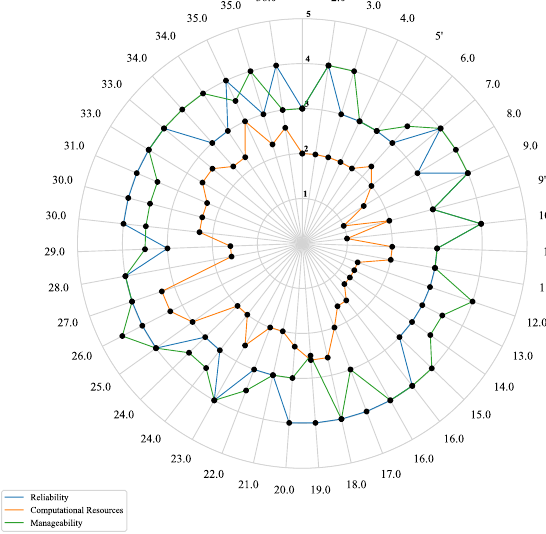
Figure 4. Attributes scores for links in the Large Customer Commercial VPP scenario, where potential critical links appear by having low scores in the different